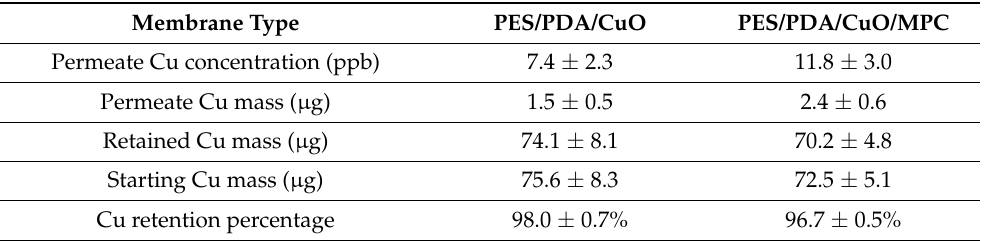
Table 1. Concentrations and masses of copper in permeate and retained on membranes. Membrane Type